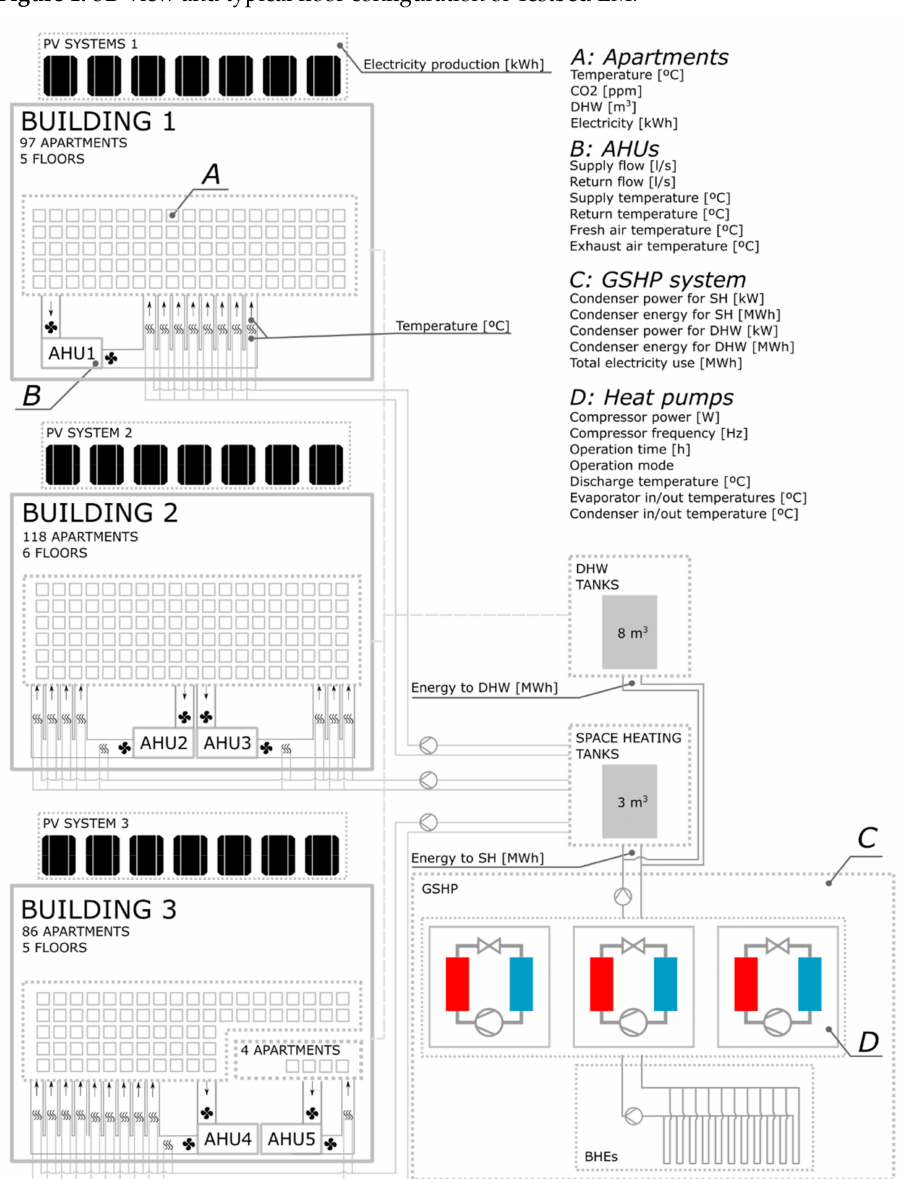
Figure 2. Testbed EM: simplified schematic of the sub-systems examined in this study with indication of the data points